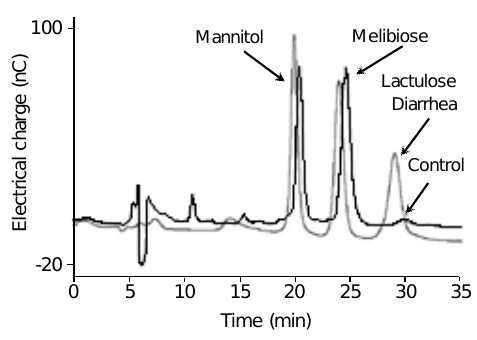
Figure 2 - Lactulose/mannitol test in children with and without diarrhea. A , A significant in- crease in percent lactulose ex- cretion is observed in the diar- rhea group compared to control children. B , Percent mannitol ex- cretion in control and children with diarrhea, with no significant difference between groups. C , The lactulose/mannitol ratio was significantly increased in the di- arrhea